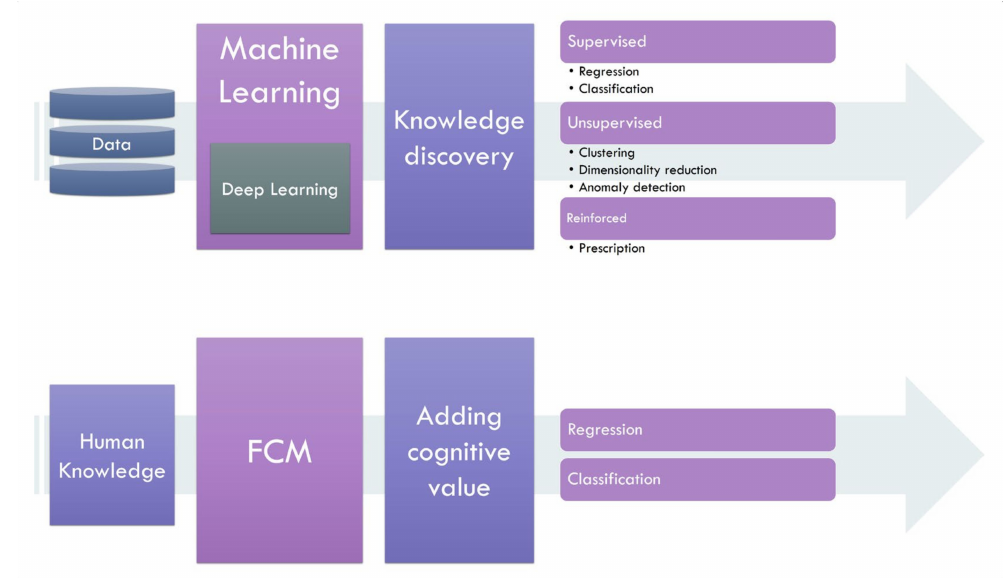
Figure 1. Machine learning and fuzzy cognitive map pipeline and tasks.